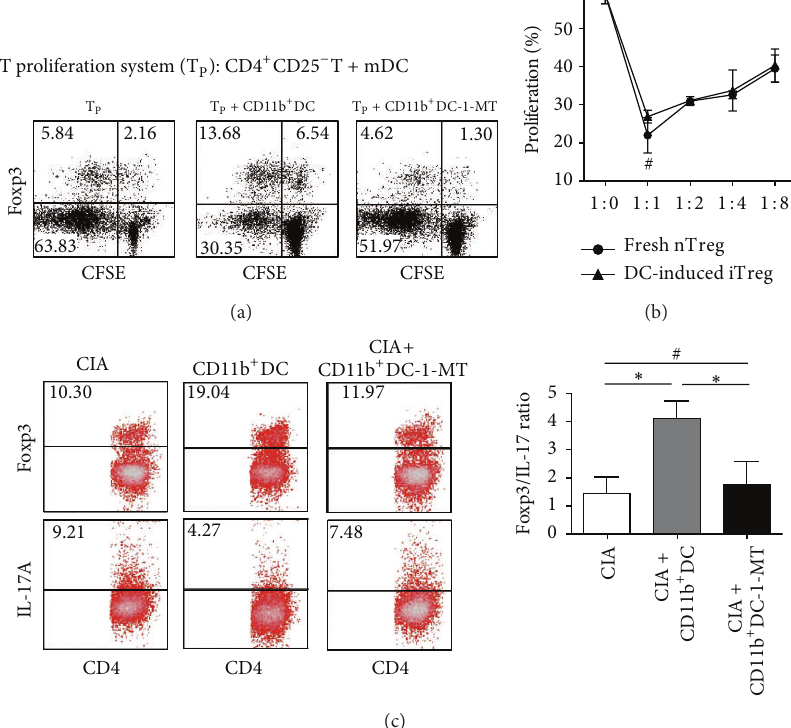
Figure 5: The conversion of Foxp3 + Tregs from CD4 + CD 25 − T cells through coculture with isolated splenic CD11b + IDO + DCs. (a) CD4 + CD25 − T cells (10 5 ) stimulated with mDCs ( 2 × 10 4 ) were cocultured for 4 days with isolated splenic CD11b + DCs (10 4 ) with or without 1-MT pretreatment. The cells were surface-stained with anti-CD4 mAbs, followed by intracellular staining with anti-Foxp3 mAbs to determine the frequency of CD4 + Foxp3 + Tregs. The dates are presented using a dot plot, expressed as the % positive cells. The results are representative of three experiments showing similar results. (b) After cocultivation for 4 days, as described in (a), CD11b + DC-induced CD4 + CD25 + T cells were isolated and used as inhibitors at different doses to suppress the proliferation of new CD4 + CD25 − T cells in response to stimulation with anti-CD3/28mAbs. The suppressive activity of freshly isolated CD4 + CD25 + T cells was also examined as a control. The proliferative responses were measured after 4 days. The data are representative of three experiments with similar results, reported as the means ± SEM. # 𝑃 > 0.05 compared with the indicated groups using unpaired t -tests. (c) CD4 + T cells from the spleens of CIA mice treated with CD11b + DC with or without 1-MT on the third week after the onset of arthritis were collected and intracellularly stained with anti-Foxp3 and anti-IL-17A mAbs. FACS was used to measure the percent frequency of positively stained cells, and the frequencies of Treg/Th17 cells are expressed as the means ± SEM of four independent experiments. # 𝑃 > 0.05 , ∗ 𝑃 < 0.05 compared with the indicated groups using unpaired t